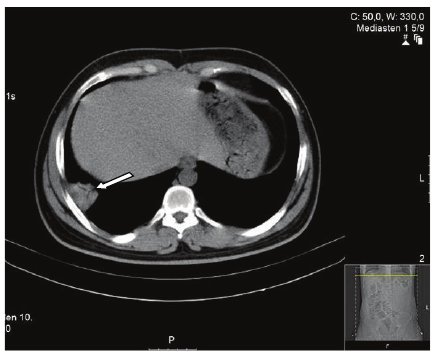
Figure 1: Wedge-like consolidated area.